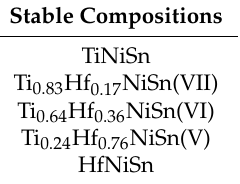
Table 6. Compositions of the stable Heusler phases with an error range of